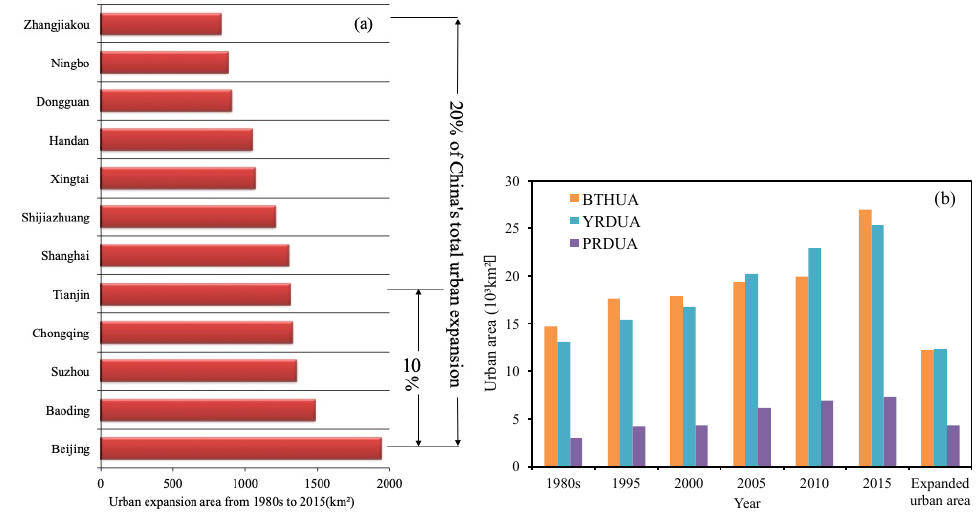
Figure 1. ( a ) Changes in urban area from the 1980s to 2015 and ( b ) changes in the urban area of the three urban agglomerations.